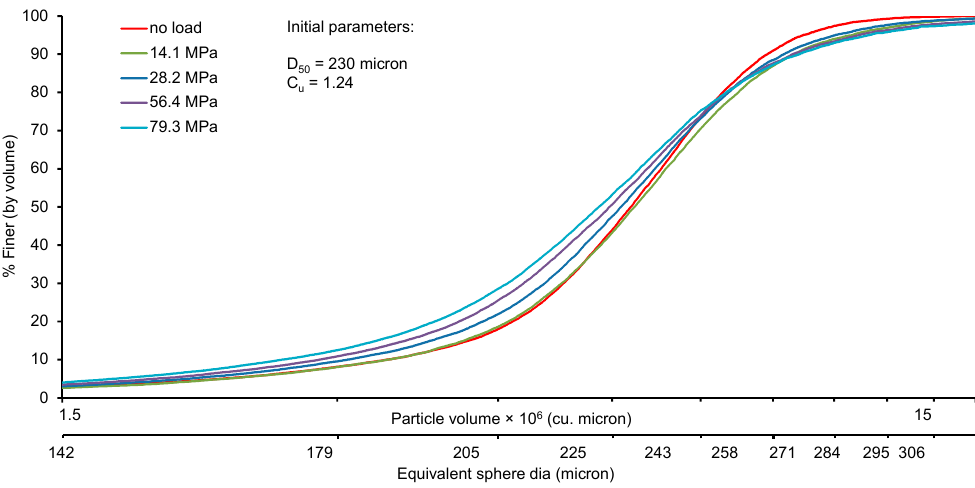
Figure 11. Evolution of particle size distribution from crushing at different loads.